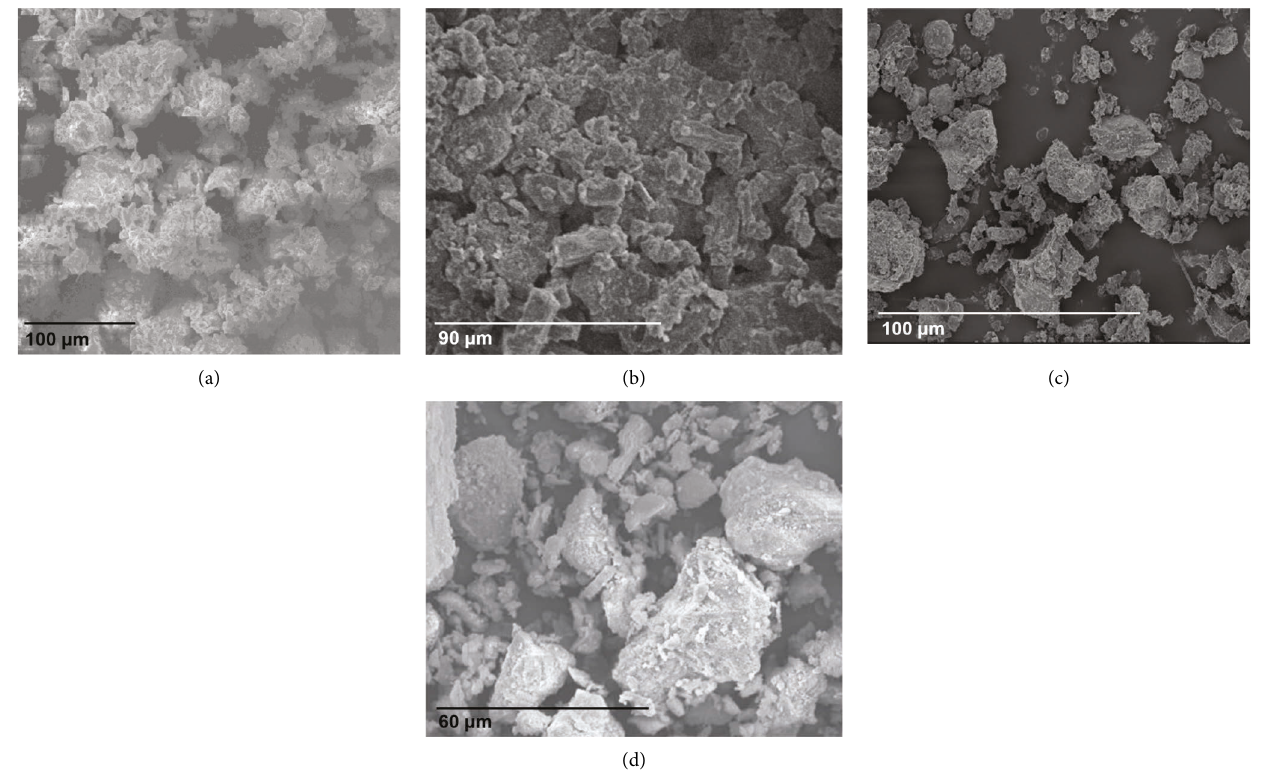
Figure 1: SEM images of LFS: (a) [24]; (b) [26]; (c) [39]; (d)